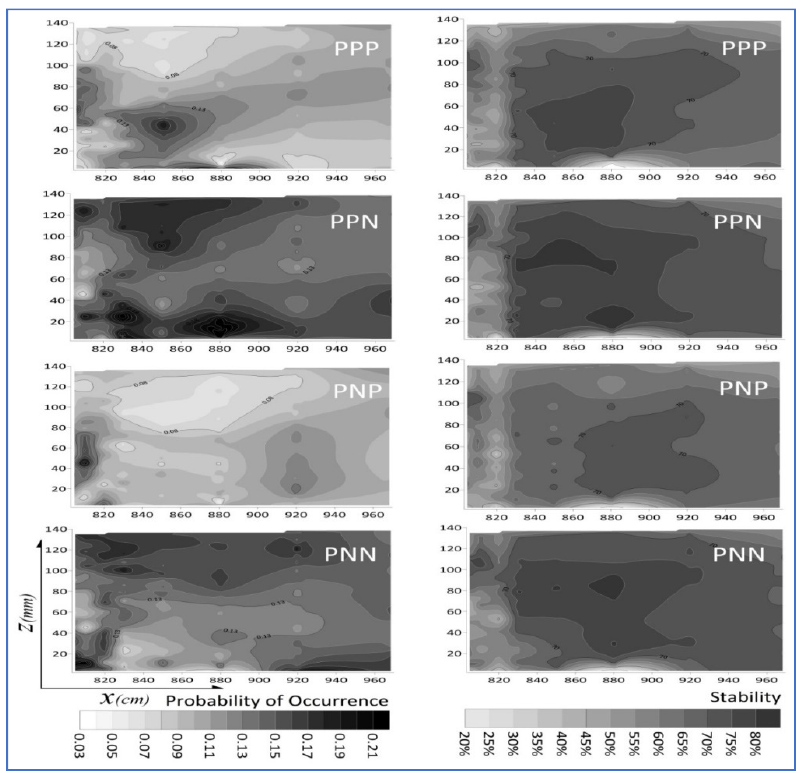
Figure 5. Probability of the occurrence and stability of octant classes PPP, PPN, PNP and PPP behind the vegetation patch. The end of the patch is located in x = 800. The height of patches is 105 ± 5 mm. The values are shown up to the level of the maximum domain of ADV capability (~140 mm).